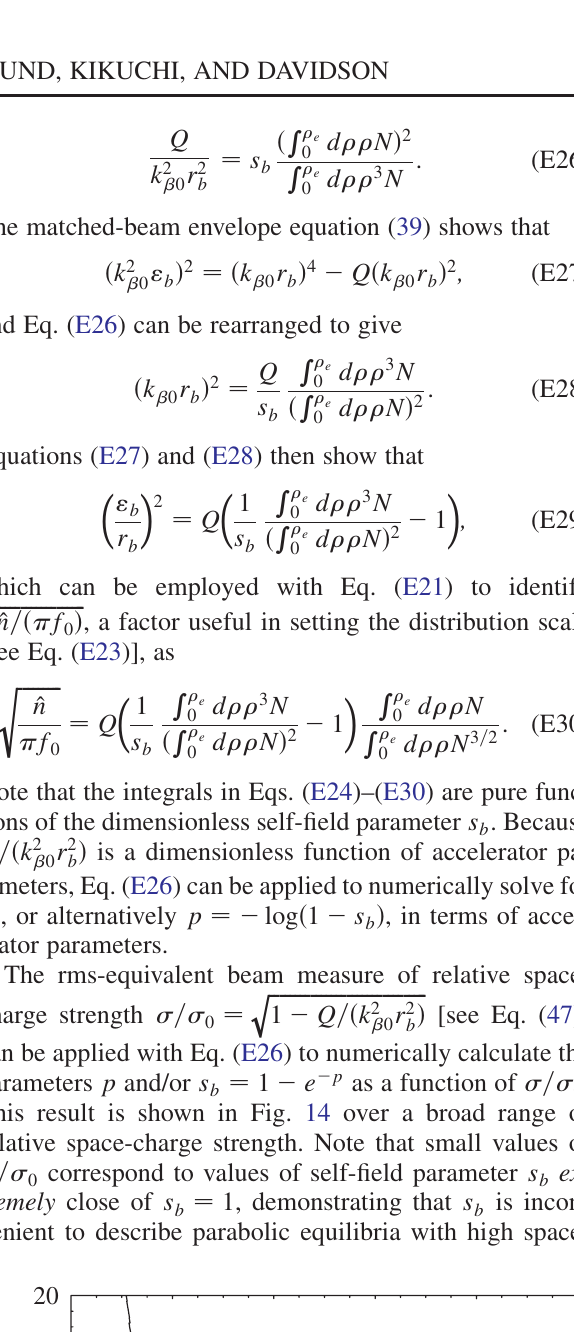
¼ 0 ð r Þ profiles are x r . Values (cid:5) 0